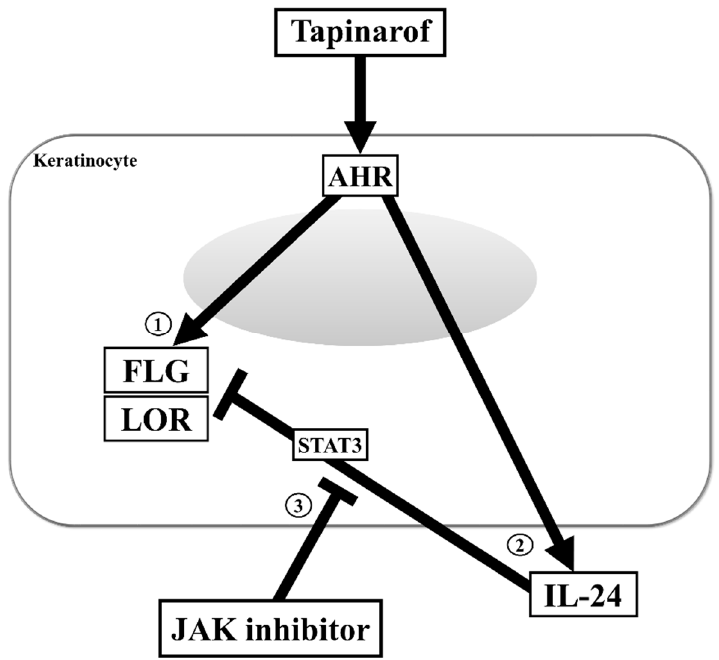
Figure 6. Inhibition of the IL-24/STAT3 axis during AHR activation enhances the upregulation of FLG and LOR expression in keratinocytes. (1) Tapinarof upregulates FLG and LOR expression in an AHR-dependent manner. (2) Tapinarof produces IL-24, an activator of the JAK/STAT3 axis that negatively regulates FLG and LOR expression, via AHR activation. (3) Blockade of the IL-24-STAT3 axis during AHR activation using JAK inhibitor supports the upregulation of FLG and LOR expression induced by tapinarof treatment.